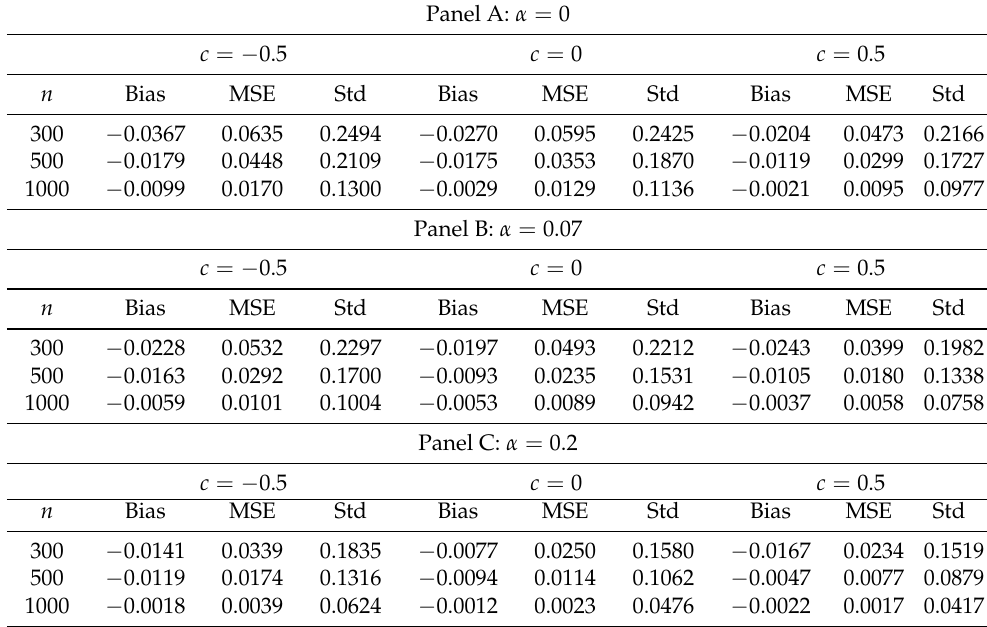
Table 1. Simulation results with ρ =